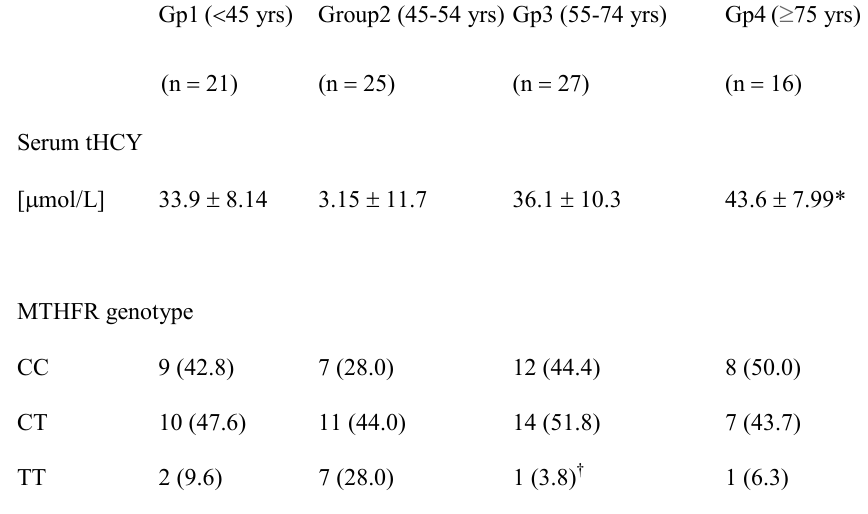
Table 2. Serum concentration of total homocysteine (tHCY) and polymorphism of methylenetetrahydrofolate reductase (MTHFR) by the four age groups in patients with cardiovascular disease.